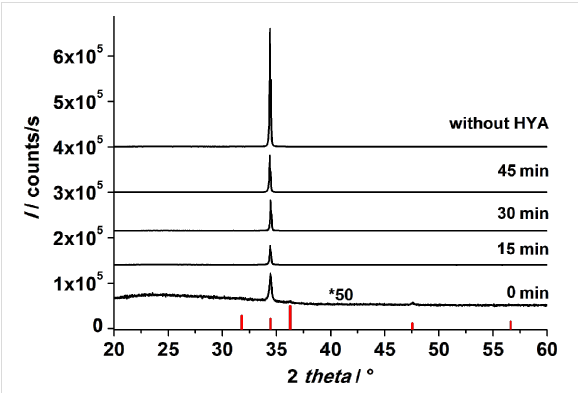
Figure 5: X-ray diffraction patterns of ZnO films after the second CBD. The films differ in the addition time of the HYA in the first CBD step (from 0 min up to 45 min). The red lines represent the XRD reflection peaks from a zincite reference [45].